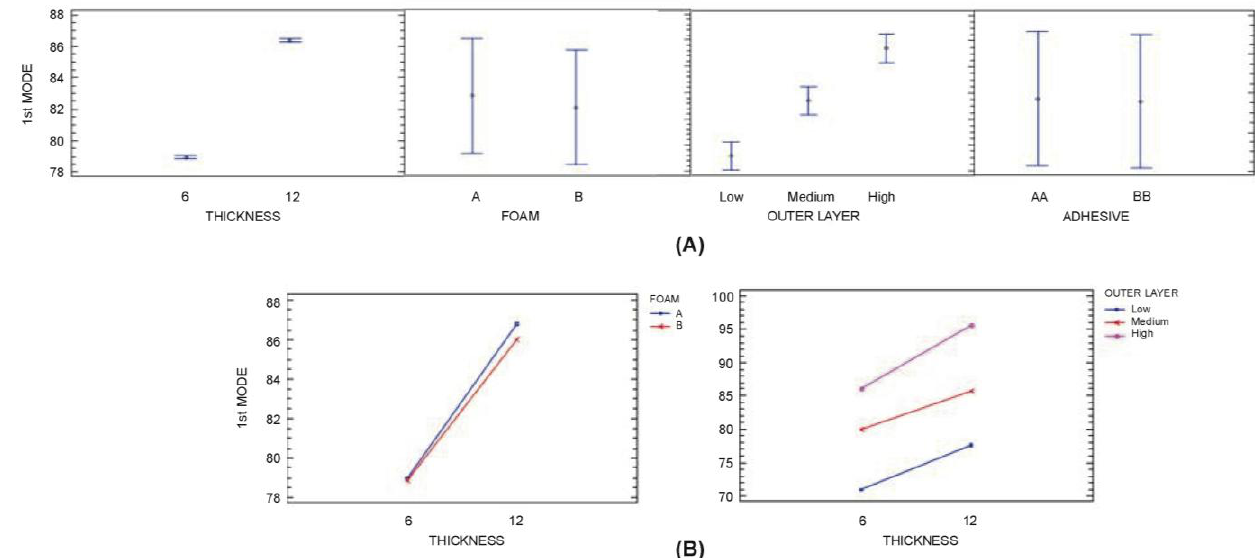
Figure 10. ( a ) 1st Mode (95% confidence interval ( b ) 1st Mode: A × B and A × C interactions (95% confidence interval).